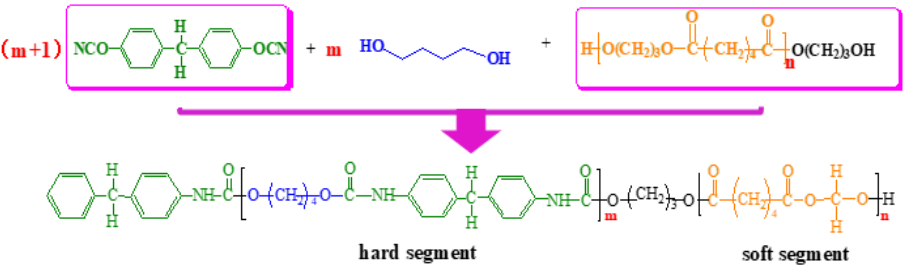
Figure 6. Chemical equation of MDI, BDO, and PBA synthetize polyester-based TPUs.